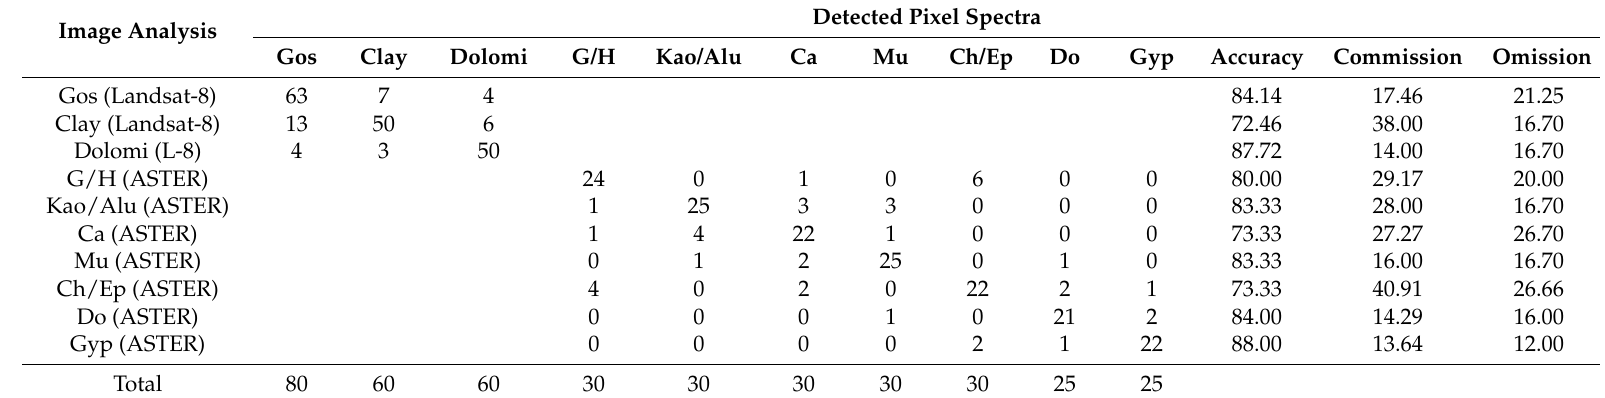
Table 5. Confusion matrix for the detected pixel spectra versus image processing